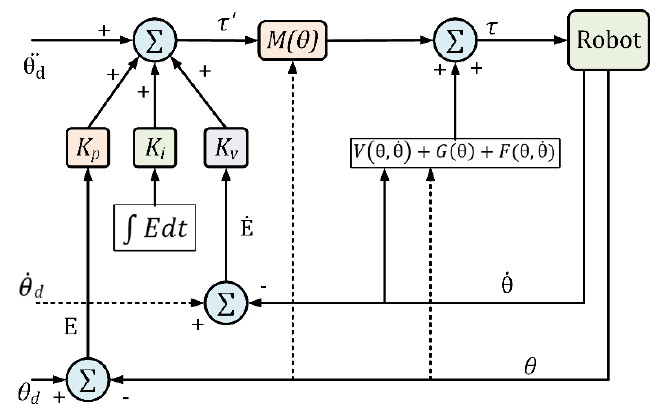
Figure 12. Computed torque control schematic.